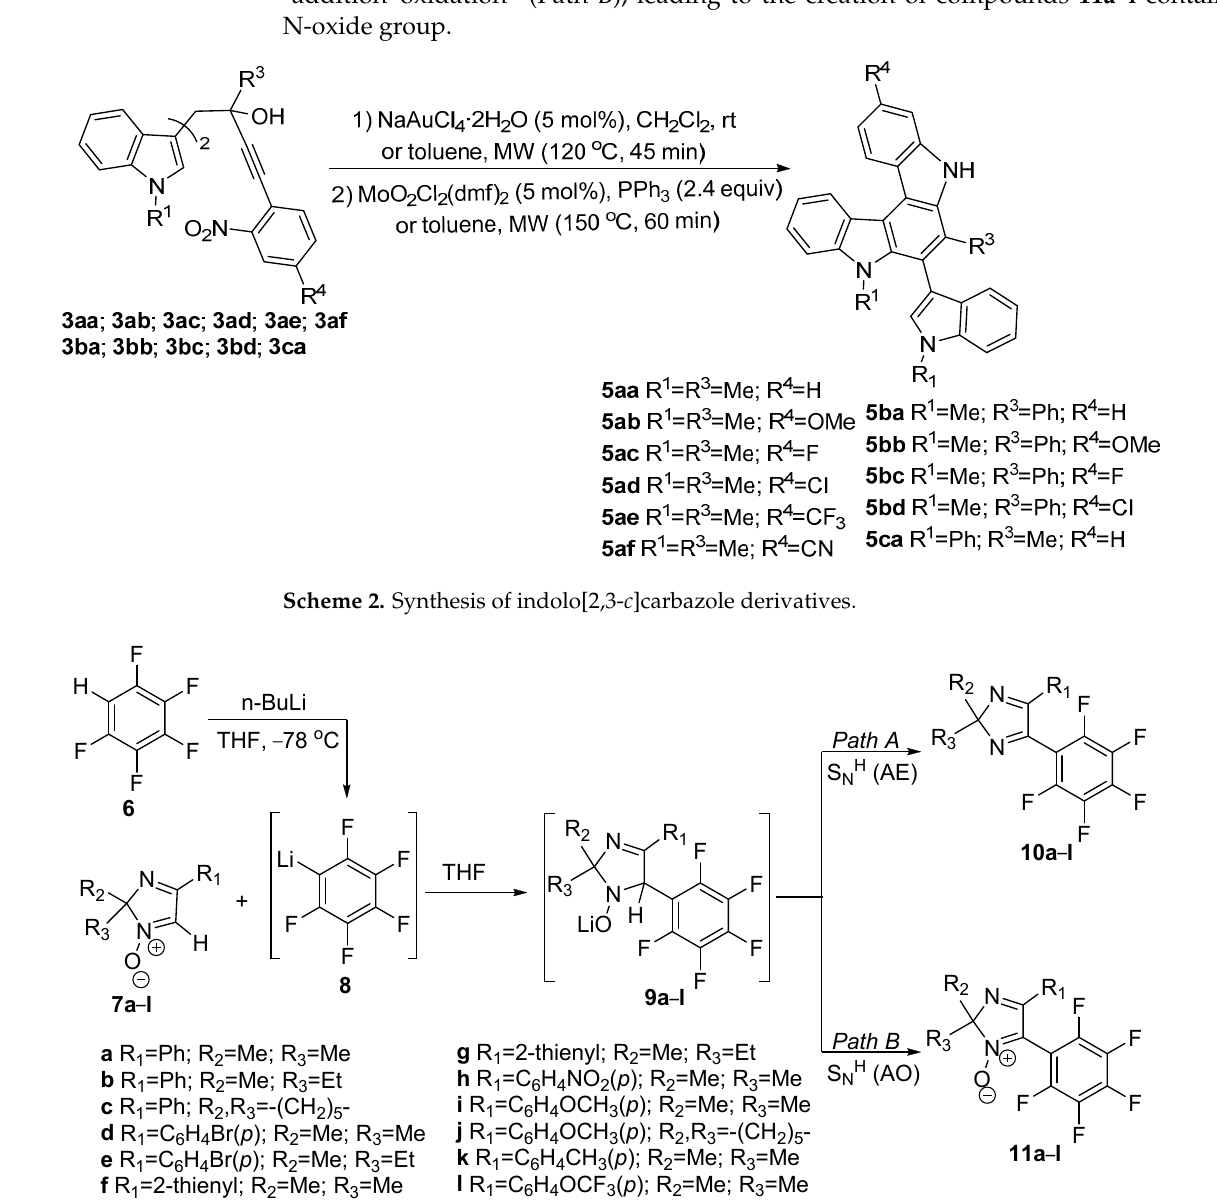
Table 1. Fluorescent properties of the selected 5aa and 5ba in